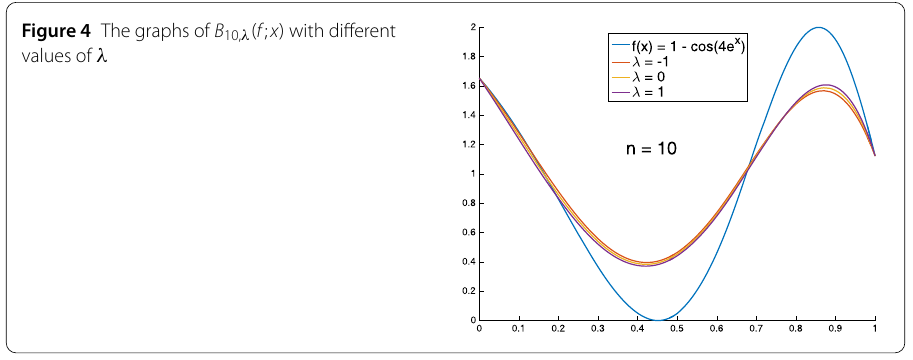
Figure 4 The graphs of B 10, λ ( f ; x ) with different values of